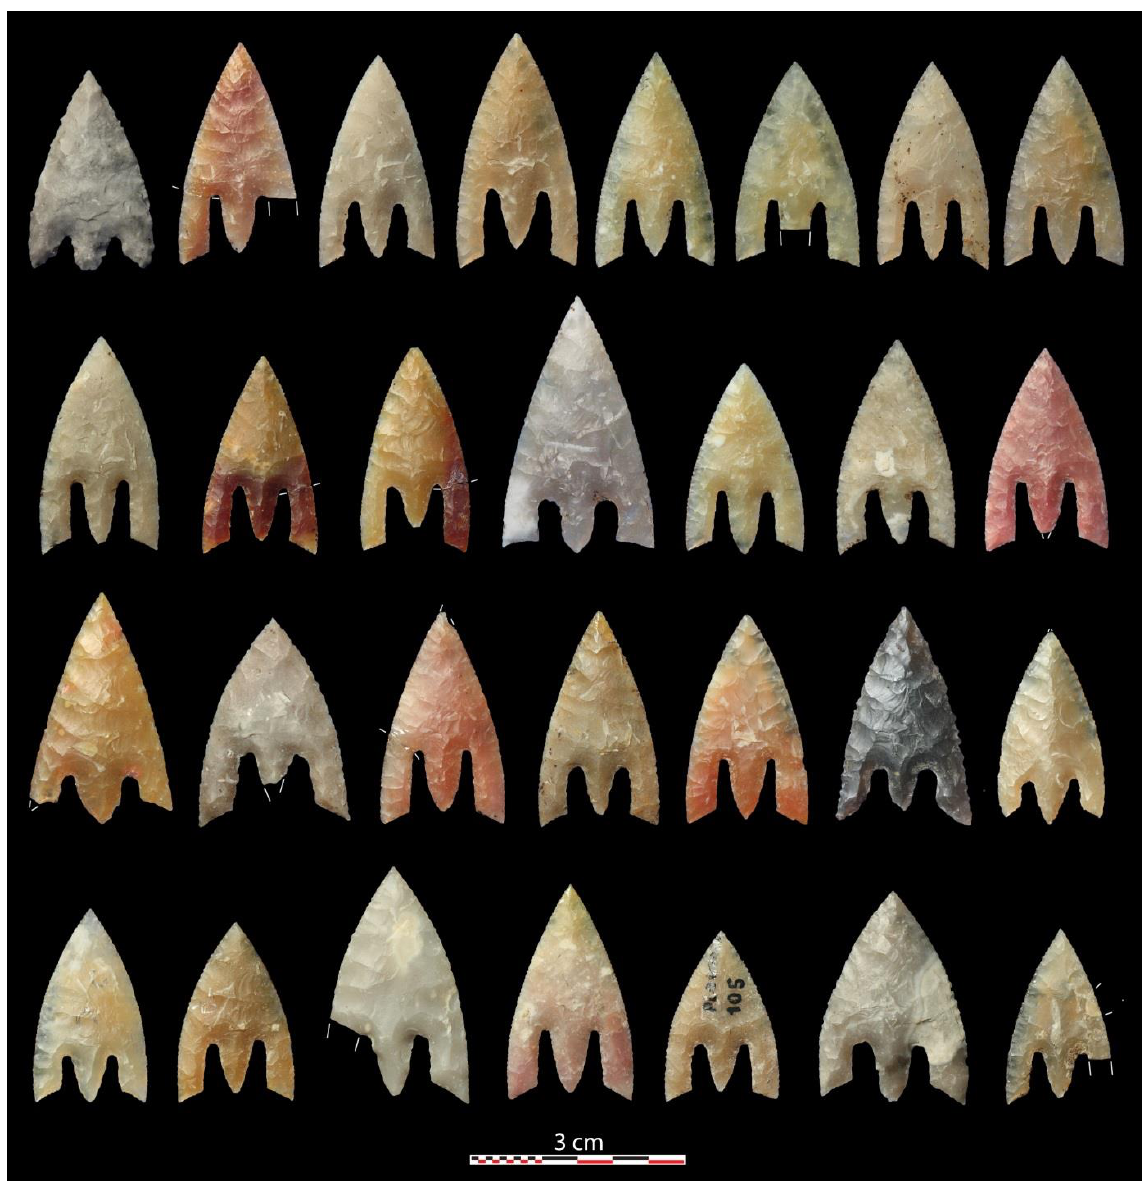
Figure 6. Arrowheads stemming from one of the wooden boxes found in the Kernonen barrow at Plouvorn, Finistère (photo C.